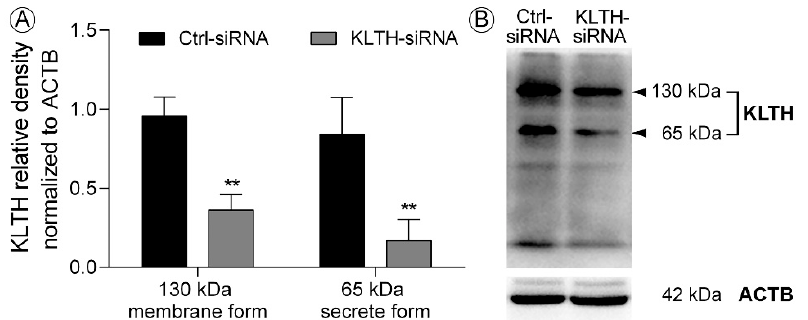
Figure 1. siRNA mediated depletion of klotho in HT-22 hippocampal neuronal cells ( A ) Western Blot analysis of klotho membrane and secreted forms expression after transfection; ( B ) representative Western Blot. Bars indicate SD, n = 3, ** p < 0.01 (one-way ANOVA and Dunnett’s a posteriori test).